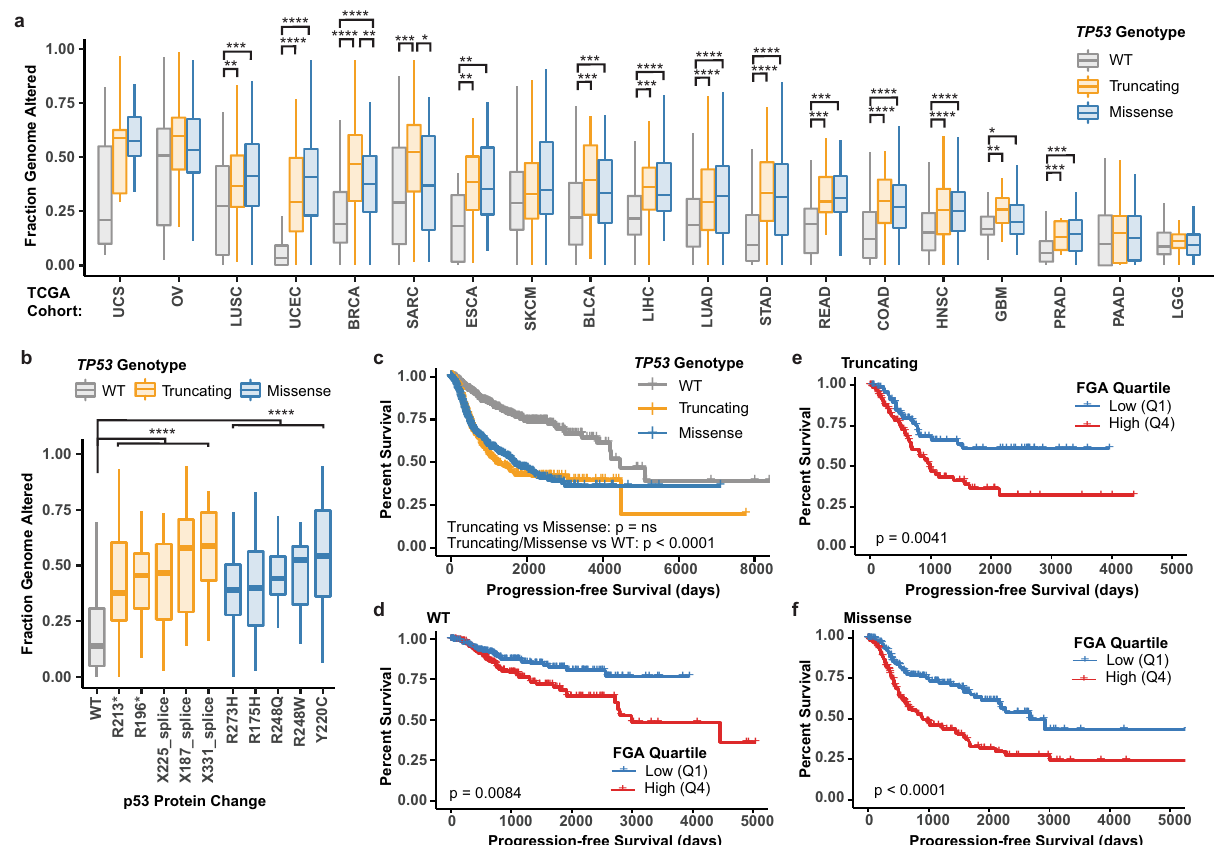
Fig. 7 Aneuploidy and loss of p53 function associate with unfavorable prognosis. a , b Box and whisker plots of the fraction of the genome altered (FGA) in tumors with wild-type (WT), missense or truncating mutations in TP53 compared a across cancer types (source: The Cancer Genome Atlas [TCGA]), or b in BRCA, OV, UCEC, UCS, and LUSC cancer types across the fi ve most frequent truncating or missense mutations. Cohort acronyms, values for n , and exact P values can be found in Supplementary Table 3 or the Source Data fi le. Pairwise two-sided Wilcoxon test with Benjamini – Hochberg P -value correction, * P < 0.05, ** P < 0.01, *** P < 0.001, **** P < 0.0001. Boxplot elements: center line, median; box limits, upper and lower quartiles; whiskers, 1.5× interquartile range. c – f Kaplan – Meier curves showing progression-free survival of individuals with BRCA, OV, UCEC, UCS, and LUSC separated by TP53 genotype ( c ) or further divided into aneuploid-low (blue, lower quantile FGA, Q1) or aneuploid-high (red, upper quantile FGA, Q4) groups in individuals with tumors containing WT ( d ), truncating ( e ), or missense ( f ) mutant TP53 . Log-rank tests. Source data are provided in the Source Data